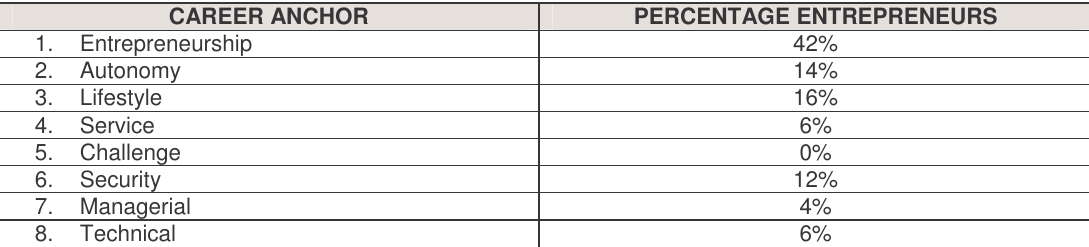
Table 4: Career anchors of successful established entrepreneurs (N=50)